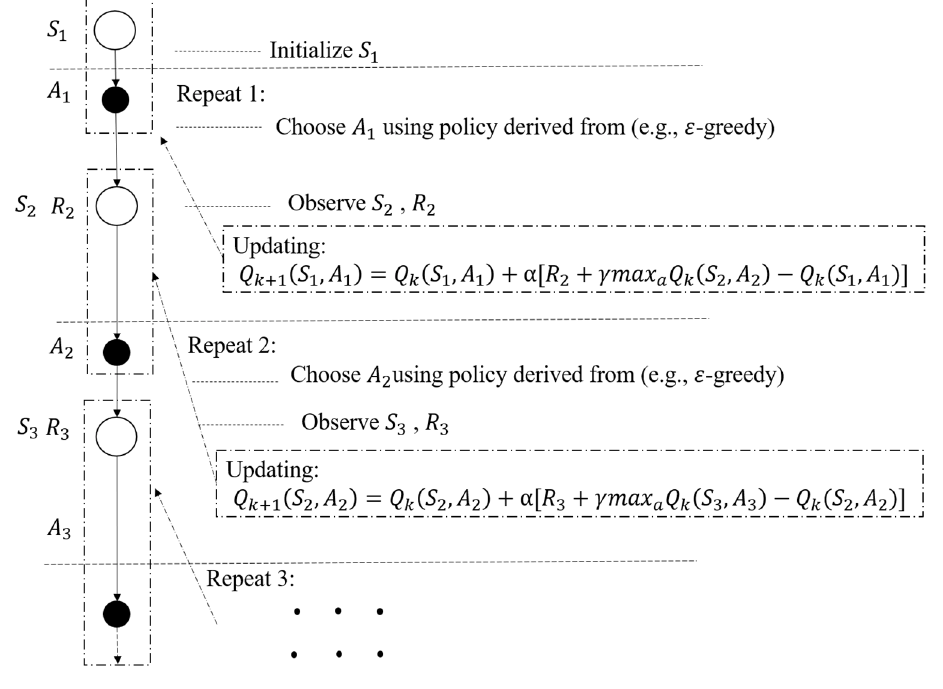
Figure 9. Q-learning algorithm procedure.